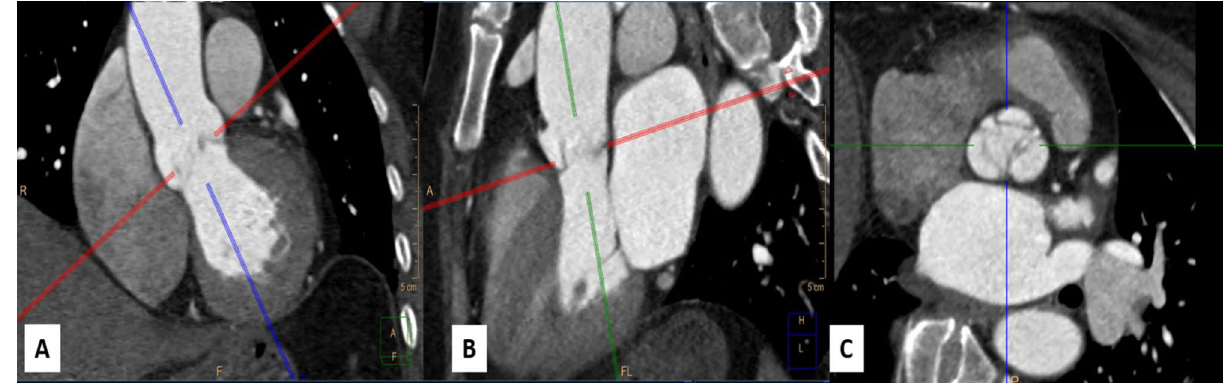
Figure 1. Short axis of aortic valve determination, on best systole phase by perpendicular lines on two orthogonal views of aorta ( A ) coronal view of aorta ( B ) sagittal view of aorta ( C ) short axis of aortic